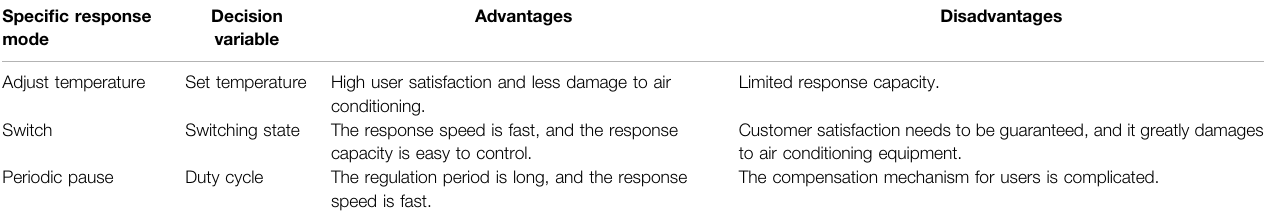
TABLE 4 | Three control methods of